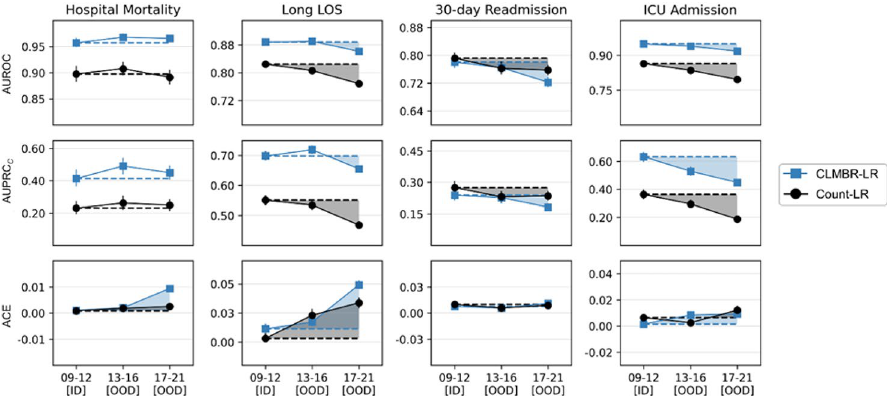
Figure 4. Performance of transformer-based CLMBR-LR and count-LR in the in-distribution (ID) year group and their decay (shaded regions) in out-of-distribution (OOD) year groups. A larger shaded region indicates more performance degradation. GRU-based CLMBR-LR results are available in the Supplementary GRU Experiment online. Error bars indicate 95% confidence interval obtained from 1000 bootstrap iterations. Raw performance scores and change in OOD performance relative to ID are provided in Supplementary Tables S2 and S3 online, respectively. AUROC Area under the receiver operating characteristics curve; AUPRC C Calibrated area under the precision recall curve; ACE Absolute calibration error; LOS Length of stay; ICU Intensive care unit; CLMBR Clinical language model-based representation; LR Logistic